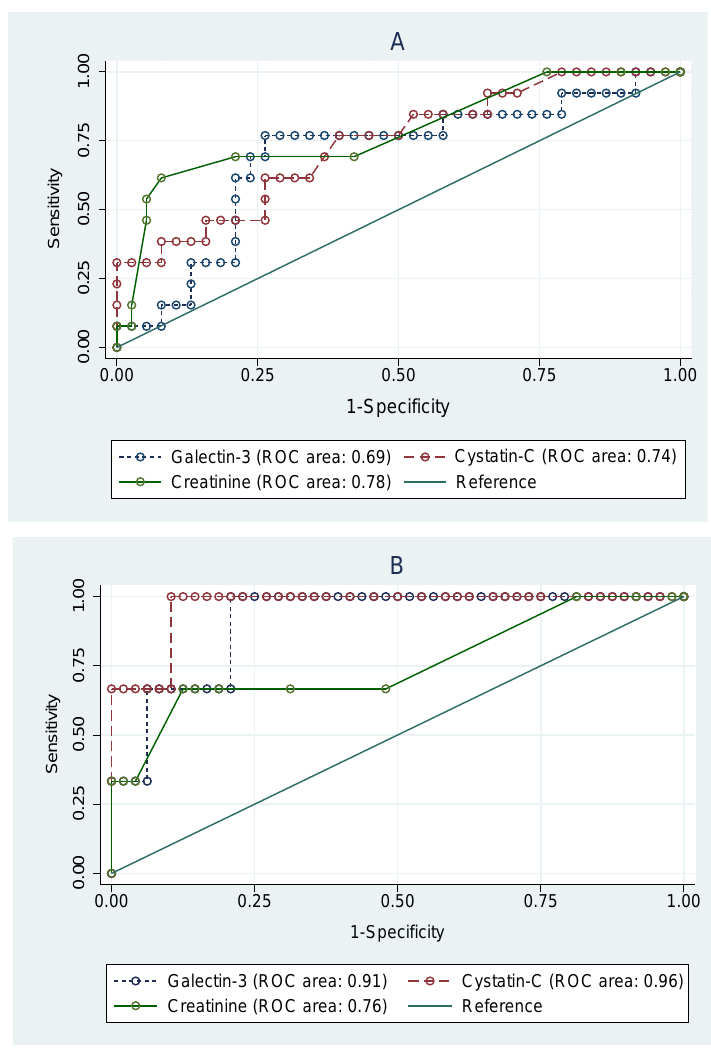
Figure 4. Receiver operating characteristic (ROC) analyses for prediction of decreased eGFR below 90 mL/min/m 2 ( A ) and below 60 mL/min/m 2 ( B ) based on the serum levels of galectin-3, cystatin C, and creatinine in congenital solitary functioning kidney children.